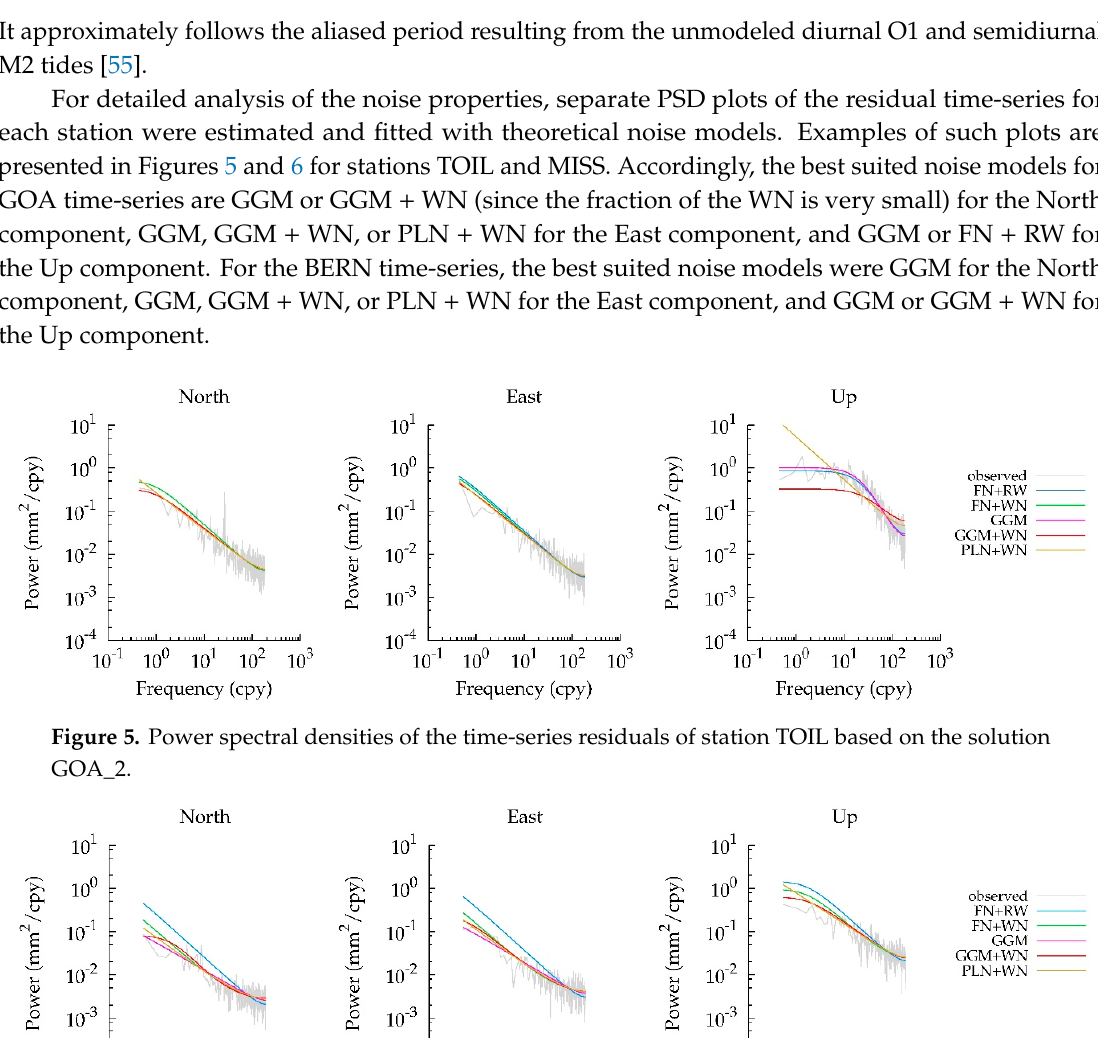
Figure 4. Power spectral densities of the BERN time-series residuals based on the solution BERN_2.